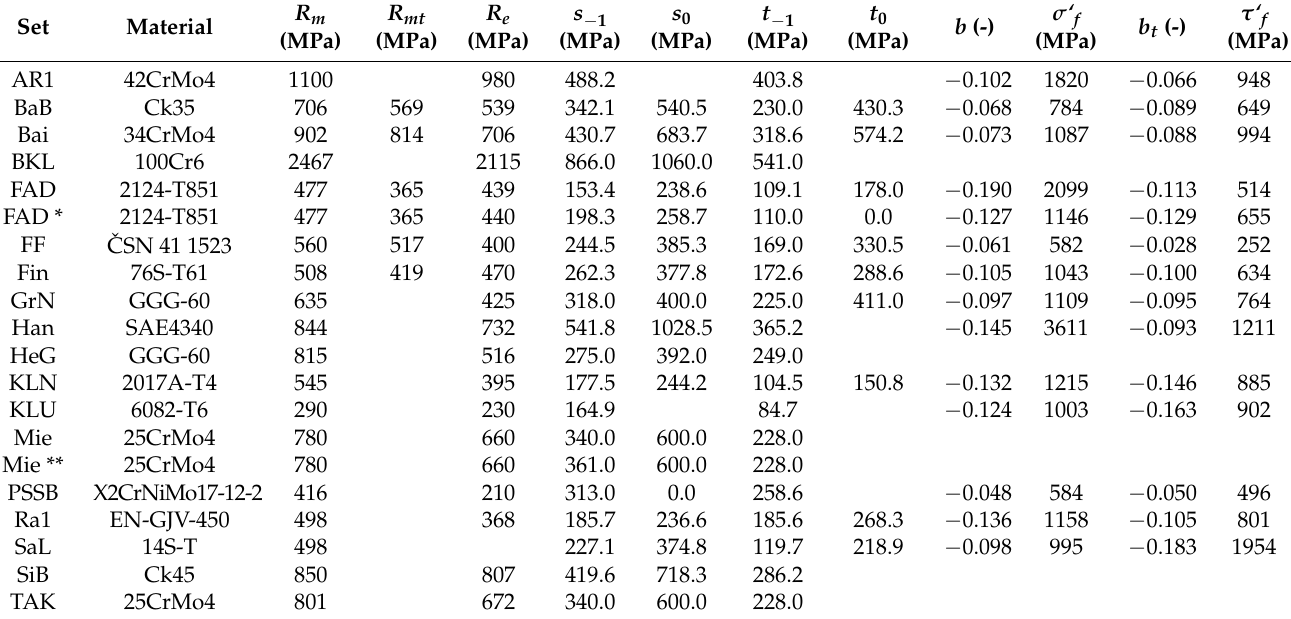
Table 2. Description of the materials used within the AMSD25 data sets and of their material parameters necessary to calculate the equivalent stresses by the criteria assessed in this paper. All fatigue strengths presented here refer to the same number of cycles as the load cases described in Tables